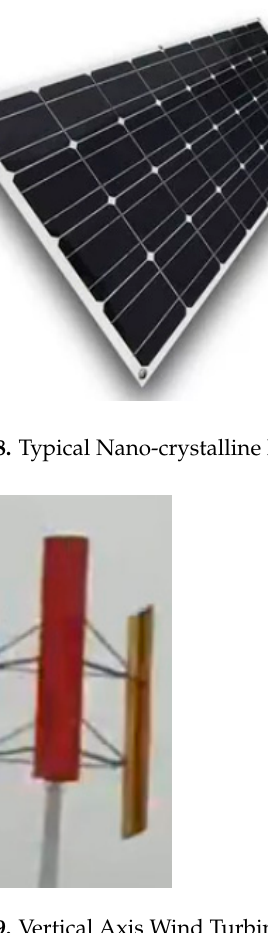
Figure 9. Vertical Axis Wind Turbine for offshore